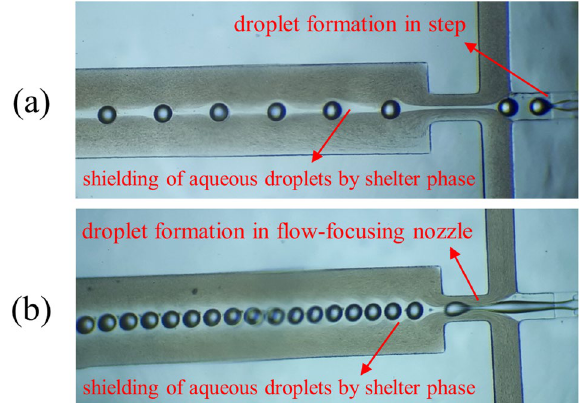
Figure 4. Shielding of aqueous phase droplets by shelter phase when aqueous droplets were formed in ( a ) step and ( b ) flow-focusing